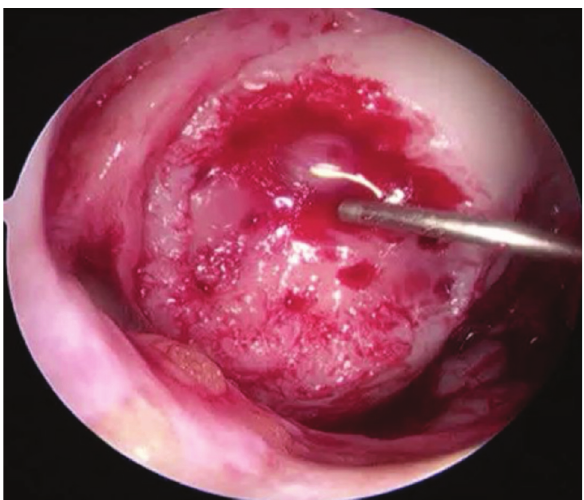
Fig. 4: Arthroscopy image. Microfracture of the cartilage defect after preparation of the